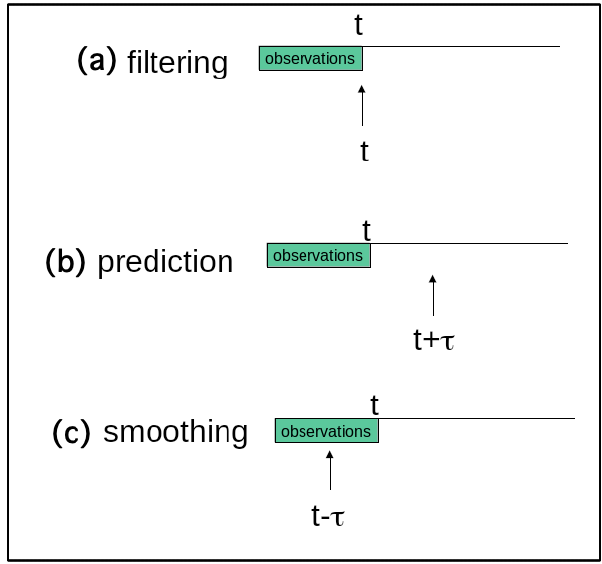
Figure 5. DBN inference tasks: filtering (monitoring), prediction, and